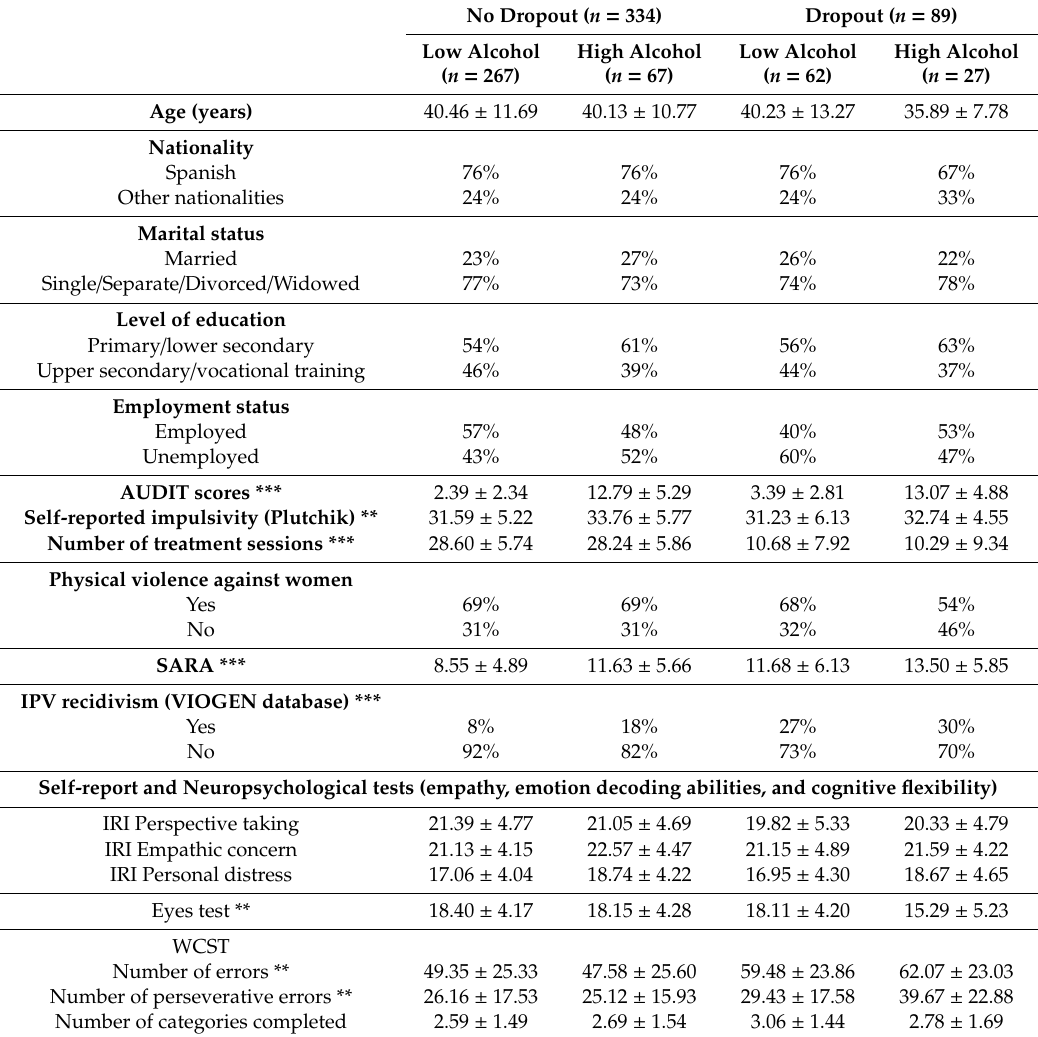
Table 1. Mean ± SD of descriptive characteristics for all groups (* p < 0.05, ** p < 0.01, *** p <